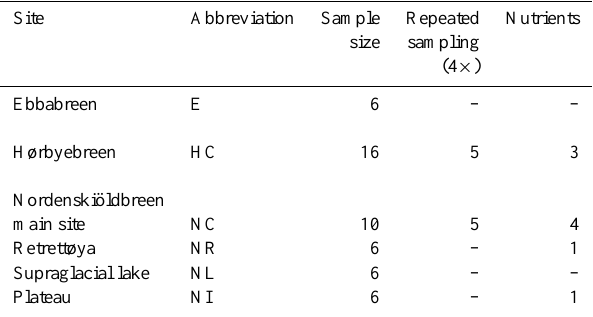
Table 1. Sampling and analysis design, with number of sampled cryoconite holes for different analyses. Sampled sites and their ab- breviations are used throughout the